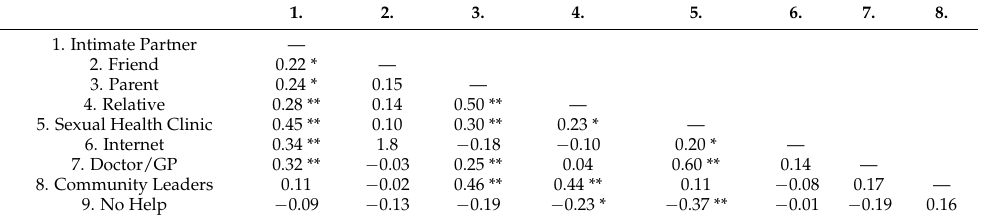
Table 4. Bivariate correlations between sources of SRH